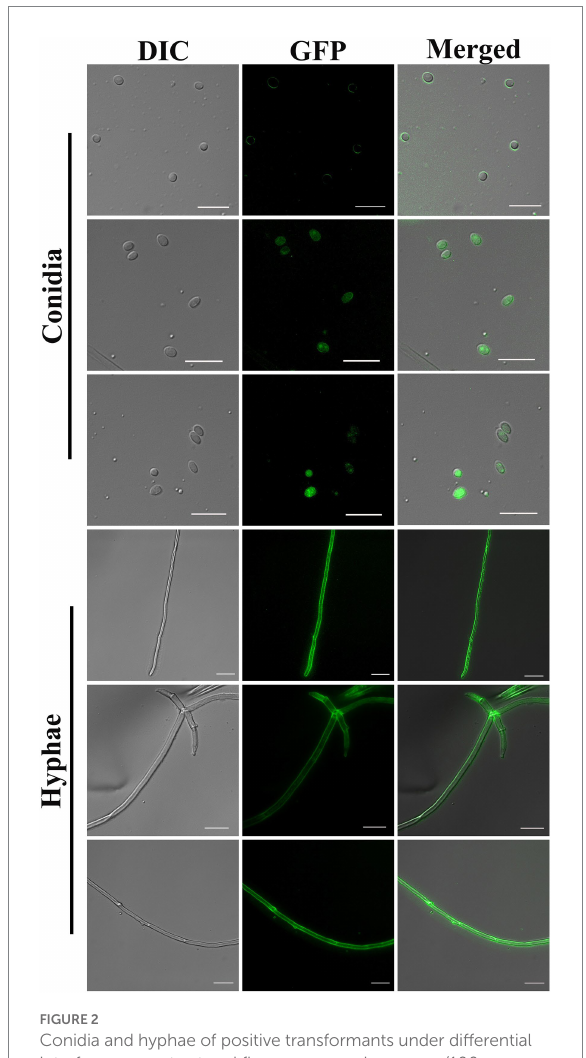
FIGURE 2 Conidia and hyphae of positive transformants under differential interference contrast and fluorescence microscopy (100× objective). Bar = 10 μ m.